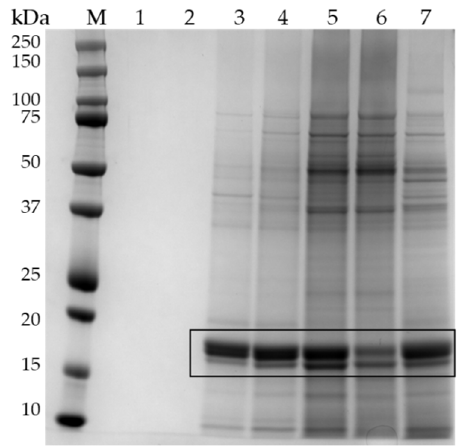
Figure 5. Representative SDS-PAGE gel (4–12%, Coomassie staining) of proteins contained in frac- tions obtained after size exclusion chromatography of cellular extracts. M: molecular mass marker; lanes 1–2: fraction 31 of samples S9 and S10; lanes 3–7: fraction 11 of samples S8, S4, S1, S9, and S7, respectively. Rectangle indicates the bands at 18 and 17 kDa containing the subunits of the phycocy- anin.